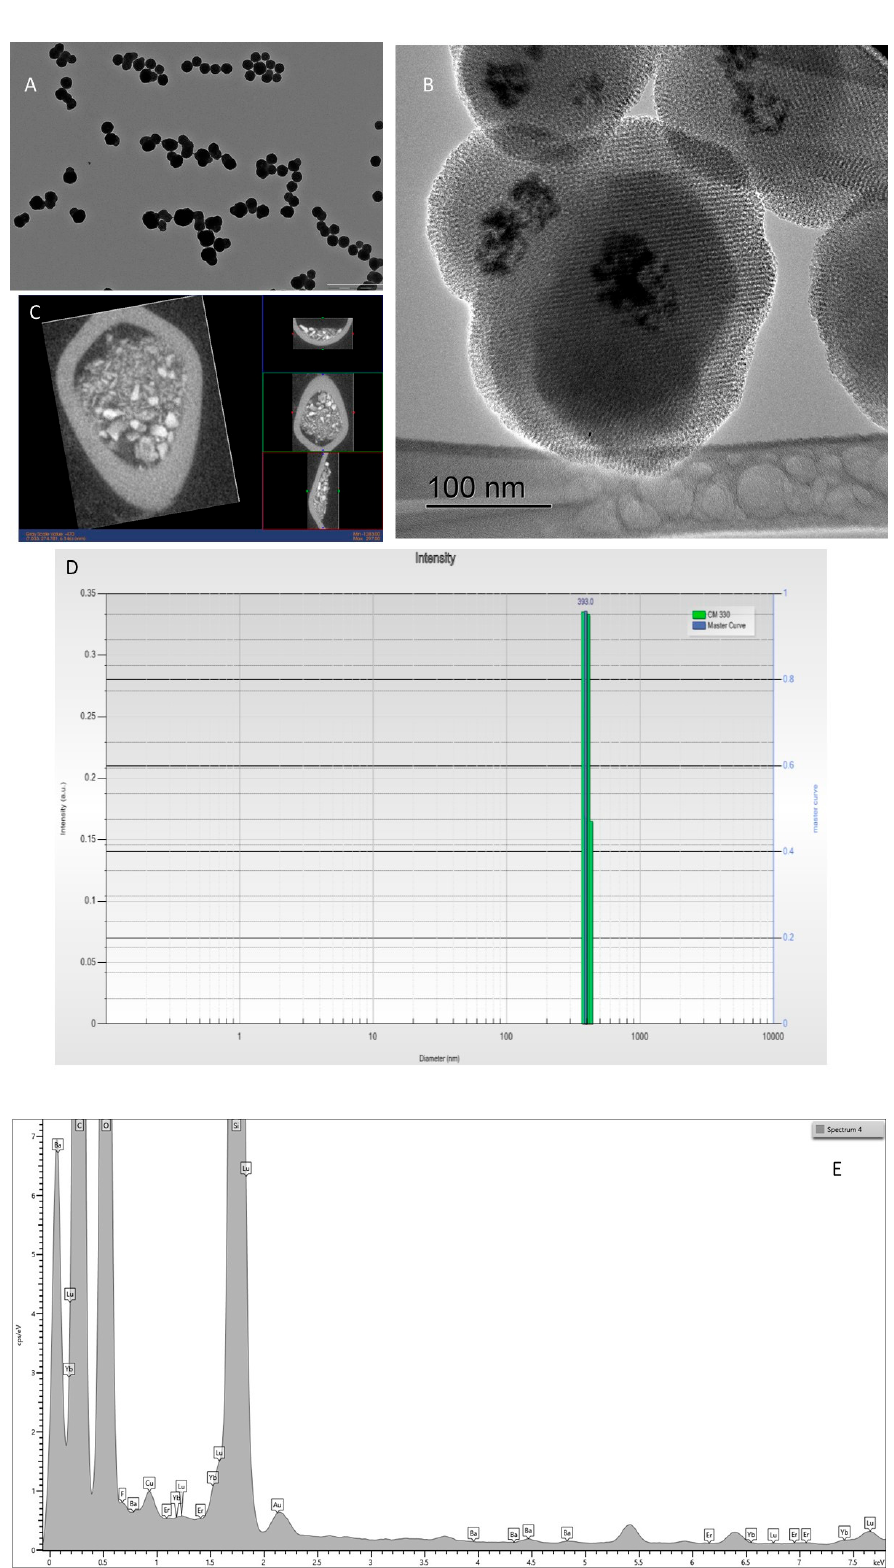
Figure 4. ( A ) TEM image of BaLuF 5 : Yb 3 + -Er 3 + @Ethane scale bar 1 µ m ( B ) HRTEM of BaLuF 5 : Yb 3 + - Er 3 + @Ethane. ( C ) X-ray computed tomography of BaLuF 5 : Yb 3 + -Er 3 + @Ethane. ( D ) DLS of BaLuF 5 : Yb 3 + -Er 3 + @Ethane in EtOH. ( E ) EDX analysis of BaLuF 5 : Yb 3 + -Er 3 + @Ethane. Si, C, O, F, Ba, and Lu elements were